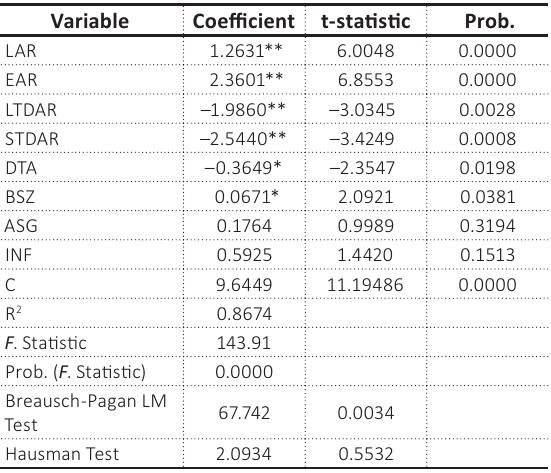
Table 5. The impact of the capital structure on banks’ performance measured by